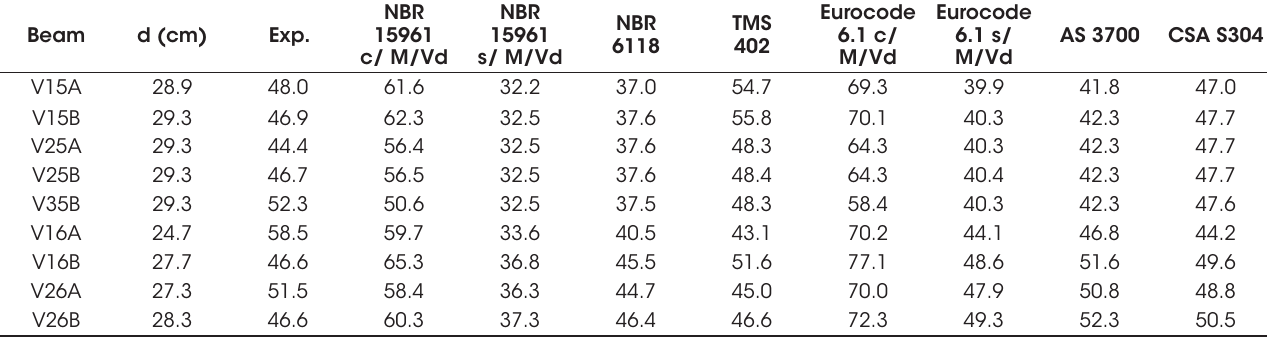
Result of maximum shear force of each test and prediction according to each standard (kN)